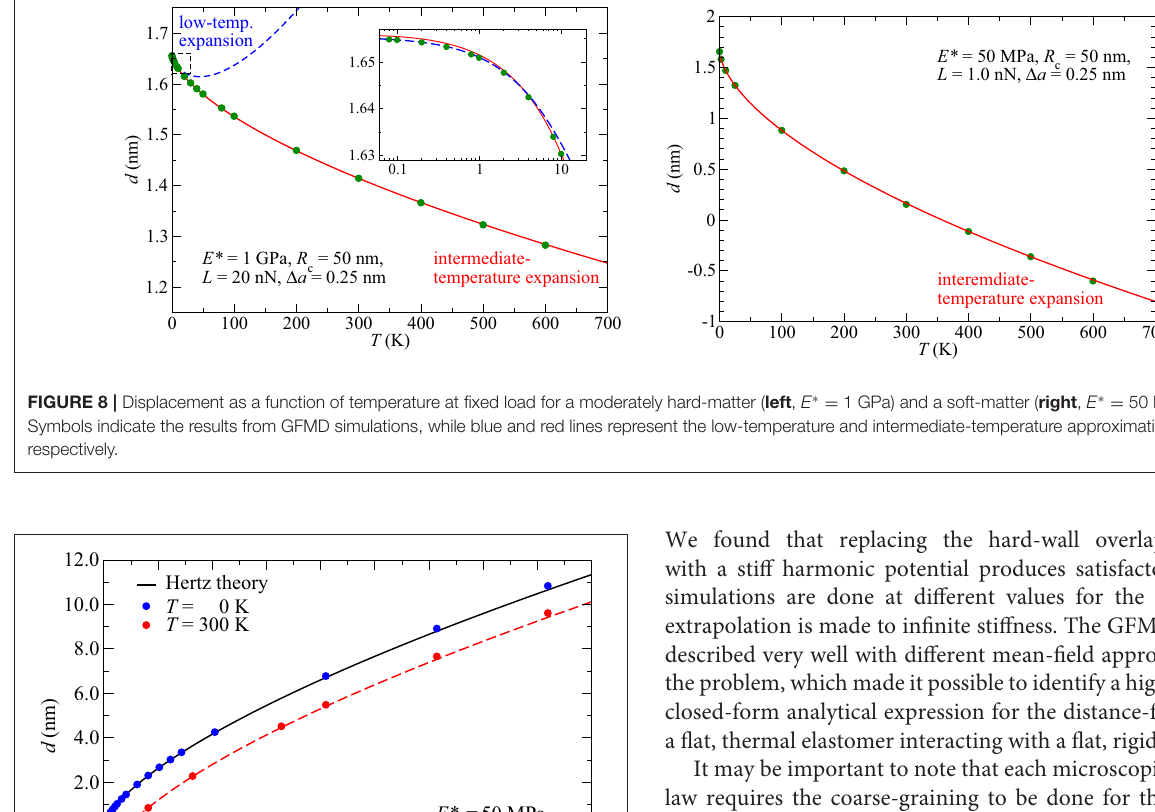
FIGURE 9 | Displacement as a function of load at zero and room temperature for a moderately hard-matter for a soft-matter ( E ∗ indicate the results from GFMD simulations, while blue and red lines represent the low-temperature and intermediate-temperature approximations,